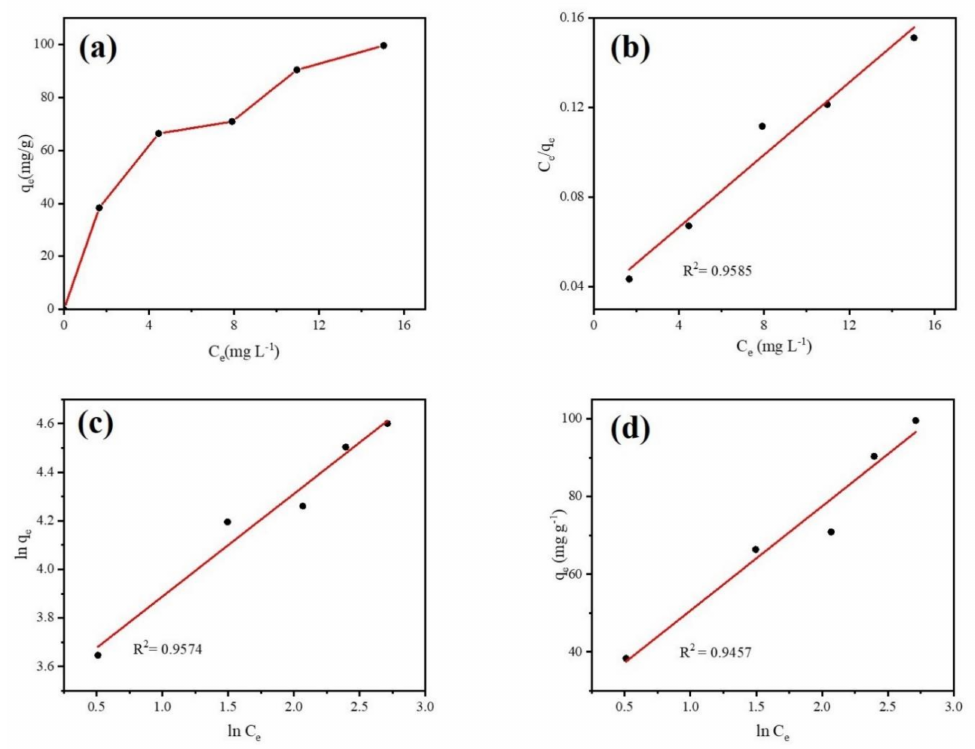
Figure 11. ( a ) Adsorption isotherms of DCF onto Fe@BC, ( b ) Langmuir, ( c ) Freundlich, and ( d ) Temkin plots for DCF adsorption over Fe@BC at 298